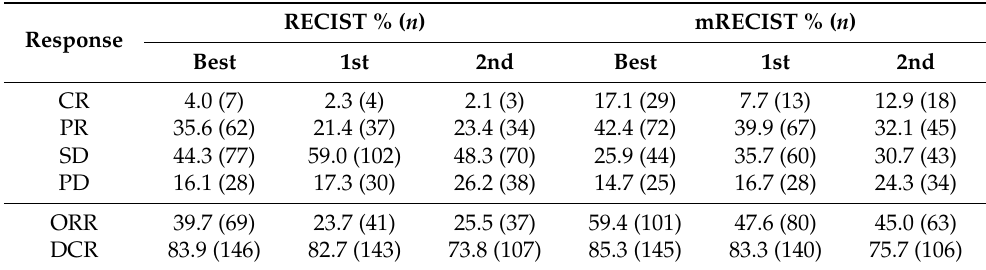
Table 2. Radiological responses to